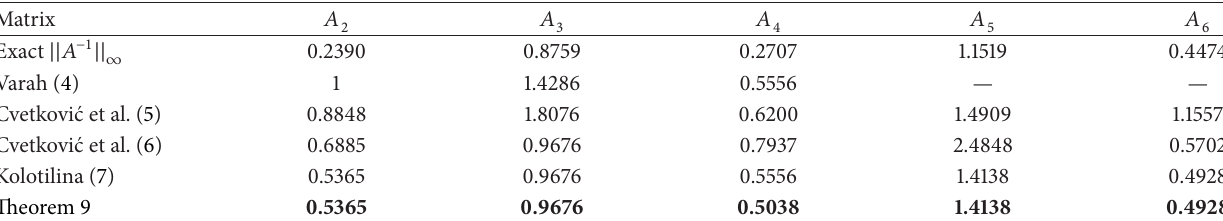
Table 1: The upper bounds for ||𝐴 −1 𝑖 || ∞ , 𝑖 = 2,...,6